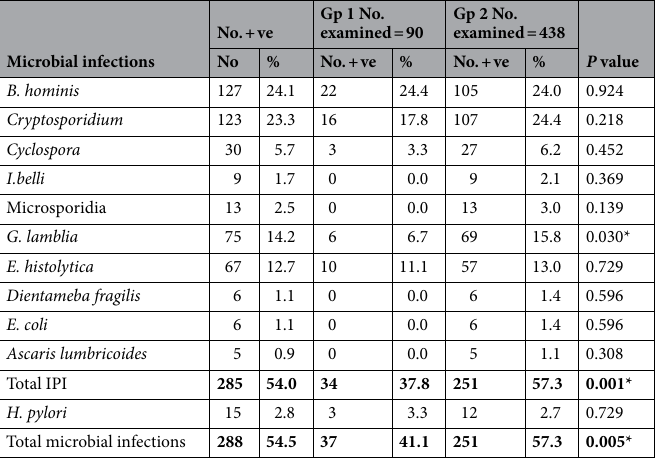
Table 4. Distribution of the microbial infections among young swimmers and their effect on the time of competition in the Winter Alexandria Championship 2020. + ve positive, IPI intestinal parasitic infection. *Statistically significant at p ≤ 0.05. Significant values are in